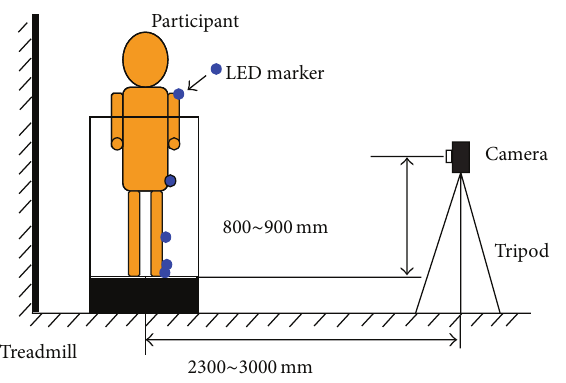
Figure 1: Walking measurement